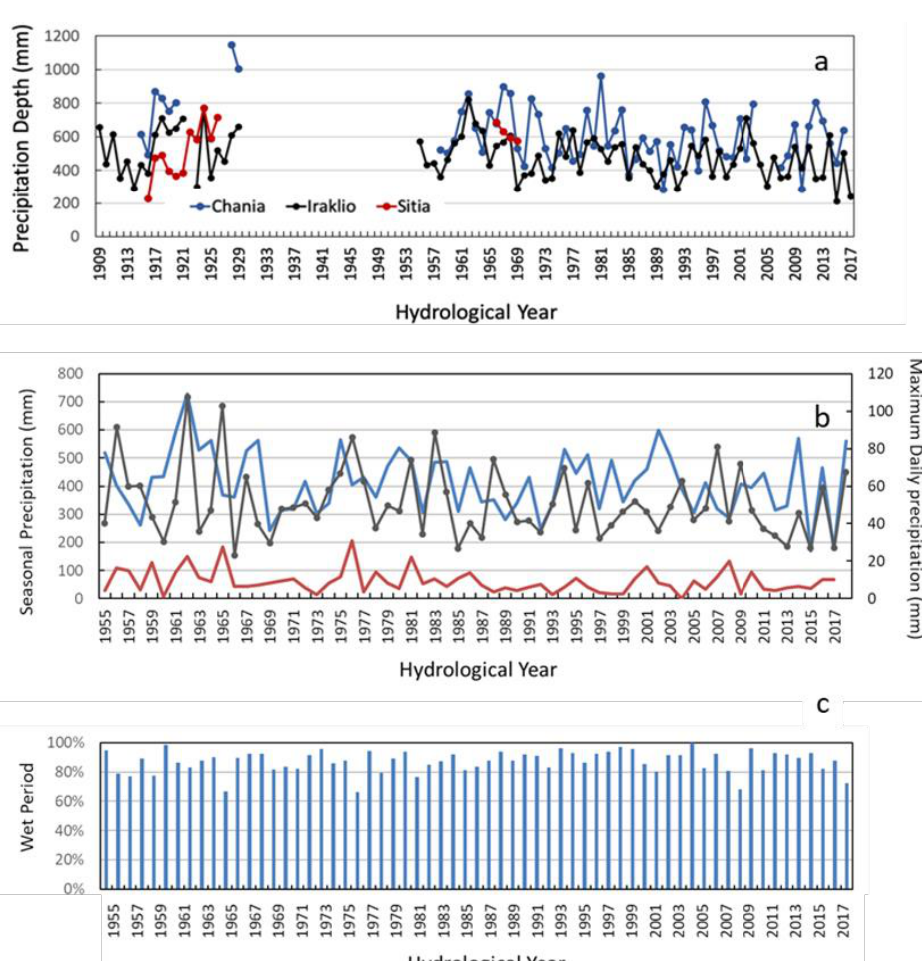
Figure 5. Precipitation in Chania, Iraklion, and Sitia from 1909 to 2017 ( a ). Precipitation in the prefecture of Iraklion, Crete, during the wet (blue line) and dry seasons (red line) ( b ). Maximum daily precipitation is given in black line (left y-axis) ( b ). Blue bars ( c ) above illustrate the wet season precipitation as a percentage of annual rainfall height (data available by the National Oceanic and Atmospheric Administration. Sources: [32,47,48] .